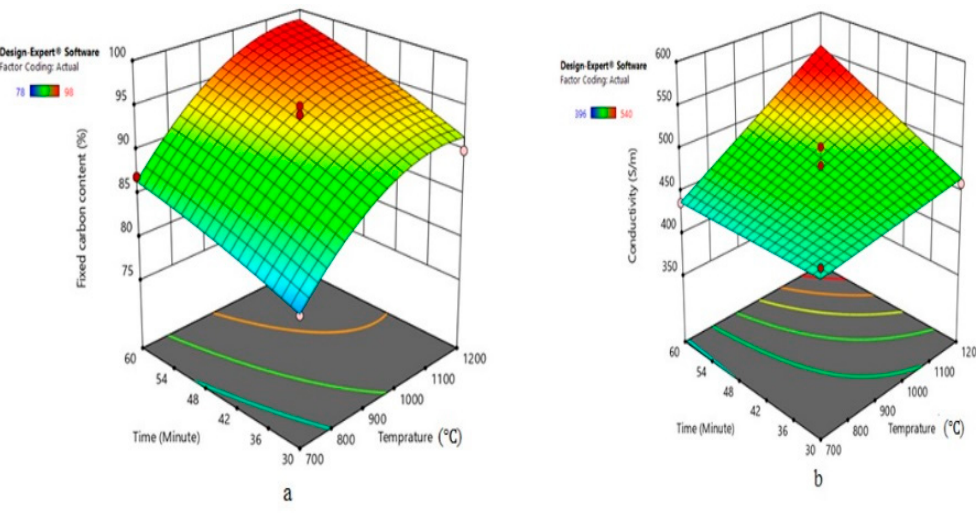
Figure 2. 3-D graph of relations of time and temperature with fixed carbon content ( a ) and conductivity ( b ).